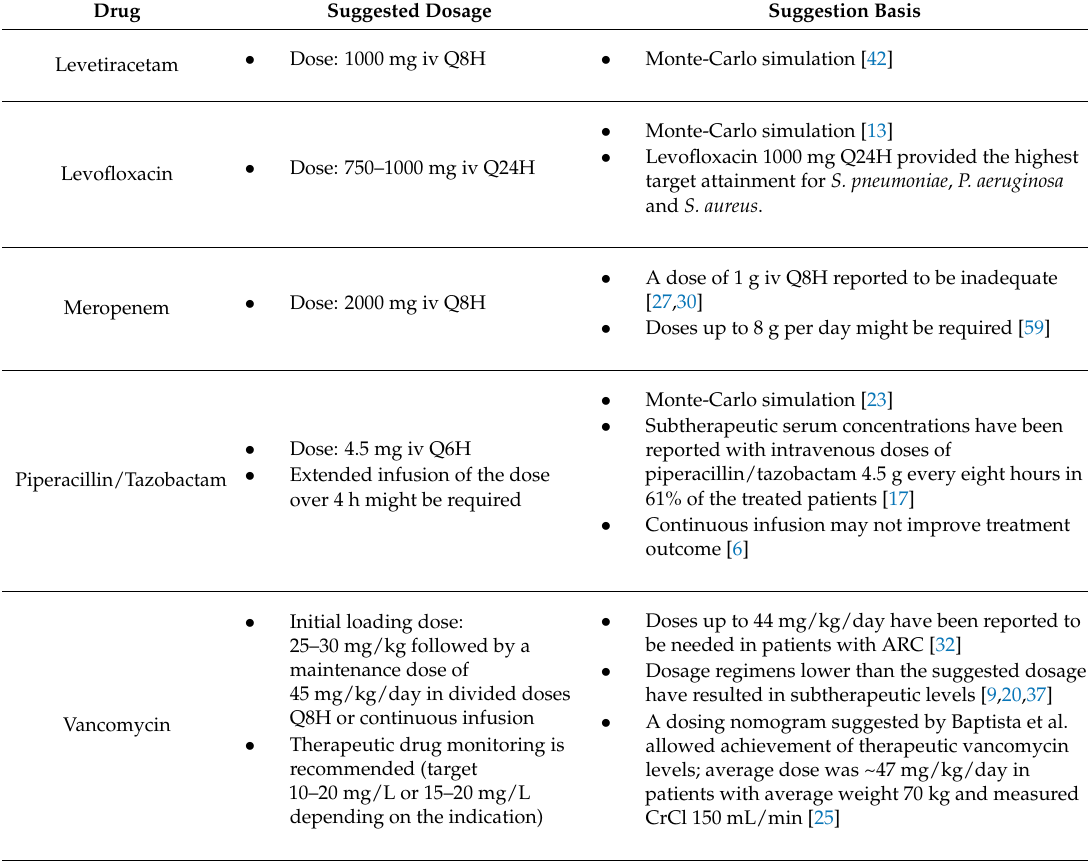
Table 3. Suggested dosing recommendations of the studied drugs in adult ARC